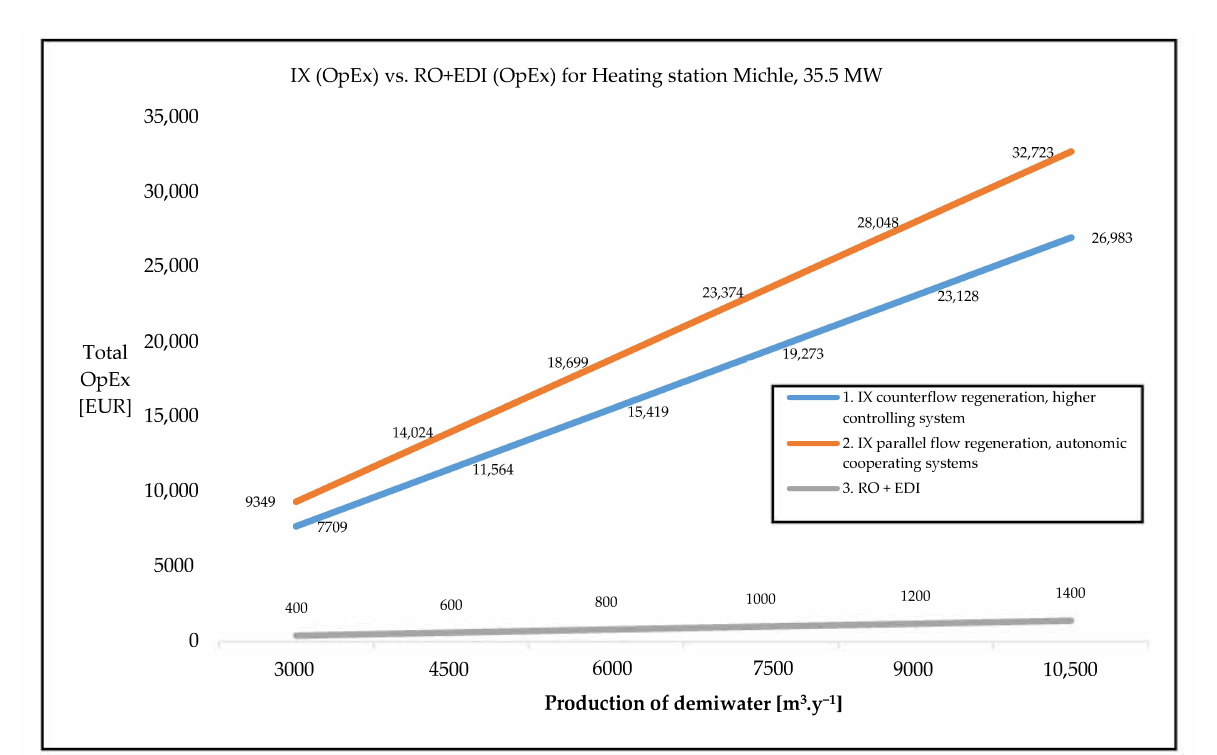
Figure 5. OpEx of IX vs. RO+EDI for small heating station Michle, Pražsk á tepl á rensk á